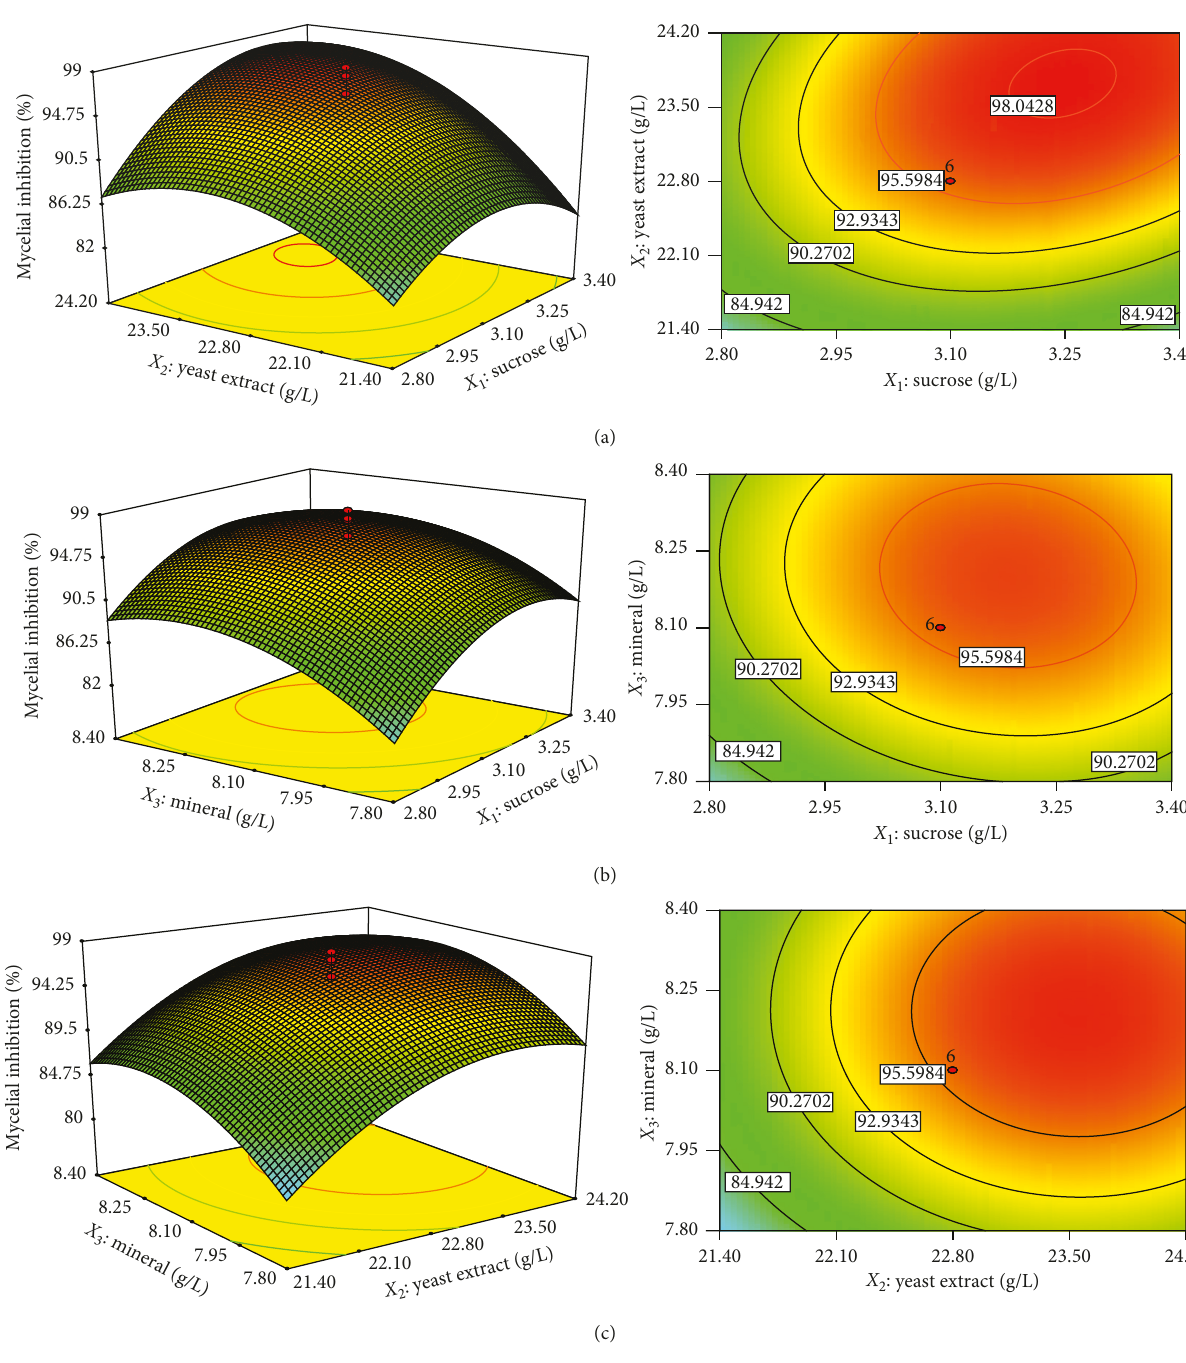
Figure 3: Response surface plots of the antifungal activity of X. stockiae PB09: (a) the effects of sucrose and yeast extract on antifungal activity; (b) the effects of sucrose and mineral on antifungal activity; (c) the effects of yeast extract and mineral on antifungal